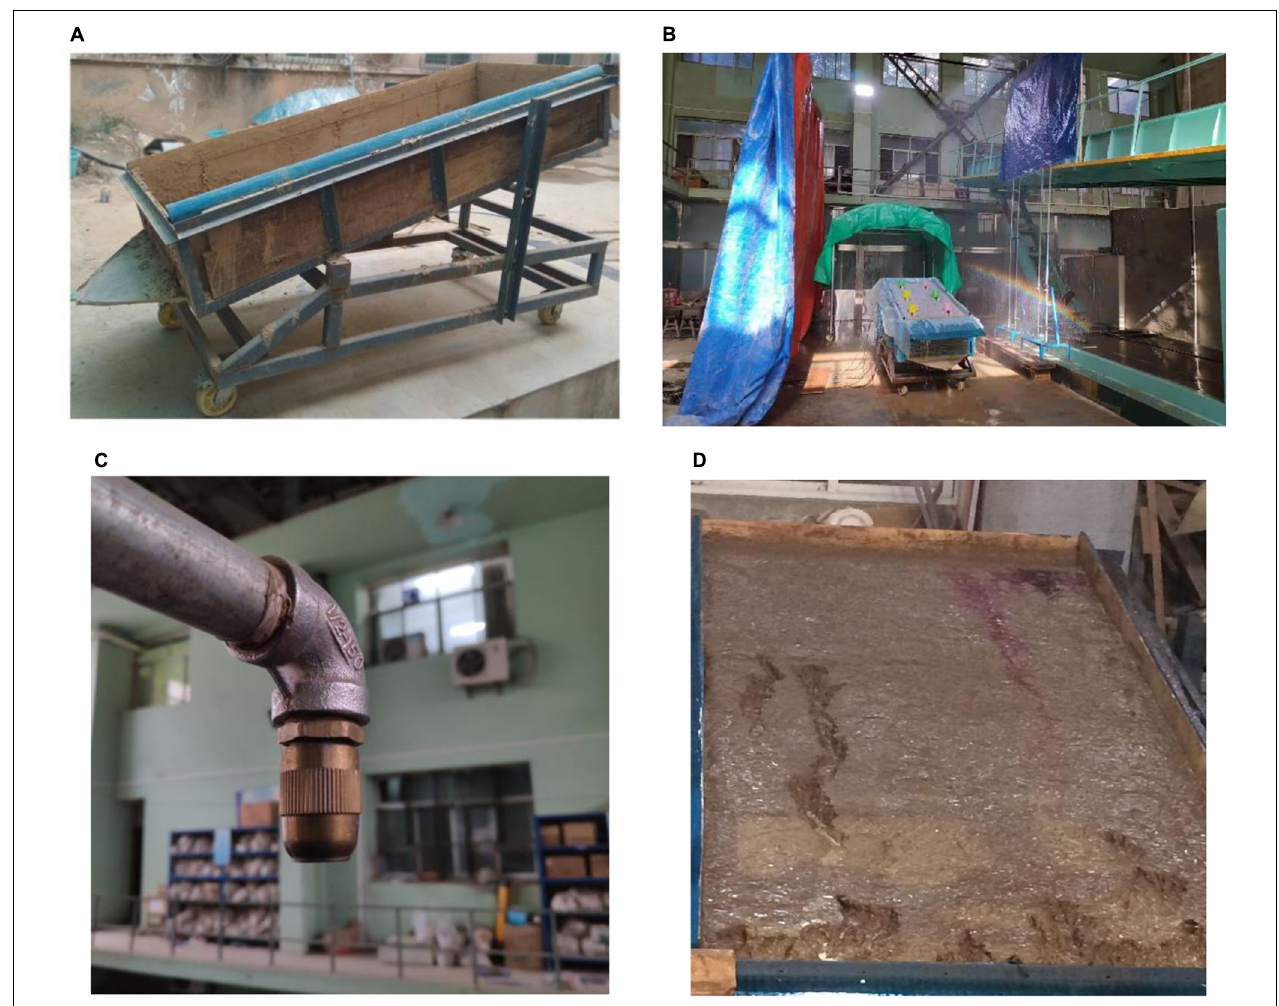
FIGURE 1 | The experimental soil flume (A) , calibration rainfall intensity (B) , rainfall simulator (C) and runoff over the flume (D) .